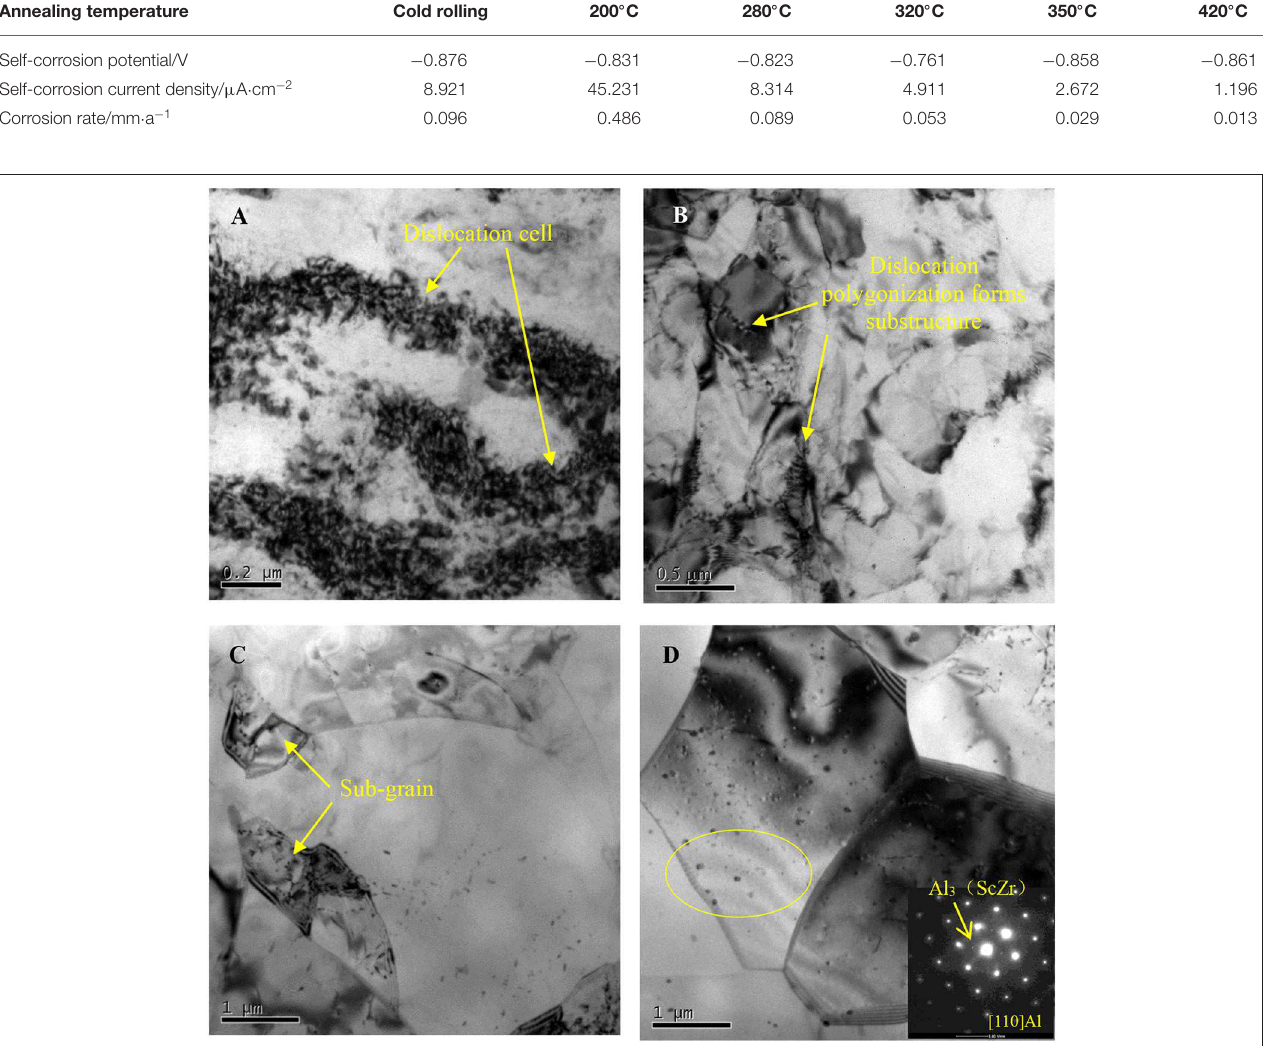
FIGURE 5 | TEM images of the Sc-containing alloy annealed at different temperatures. (A) Cold rolling; (B) Annealed at 350 ◦ C for 2h; (C) and (D) Annealed at 550 ◦ C for